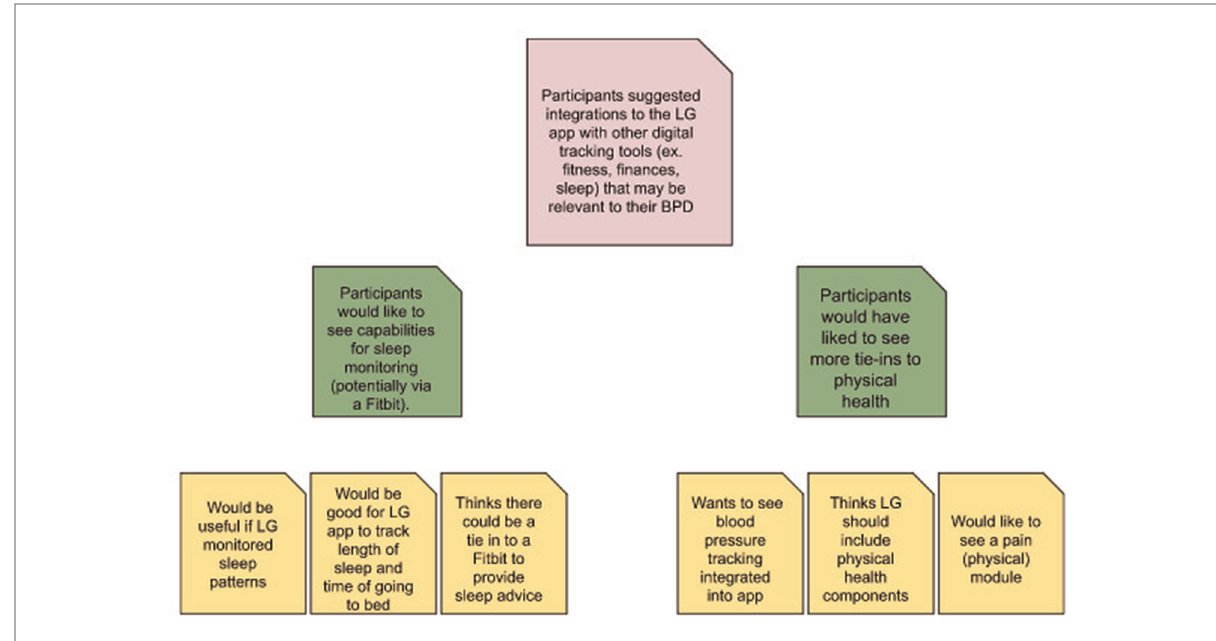
FIGURE 3 Example of the af fi nity mapping